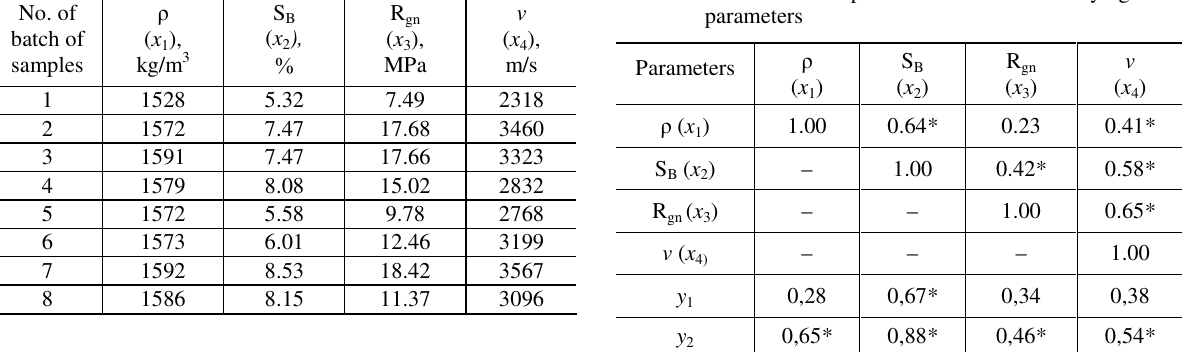
Table 5. The double correlative matrix of the analysed physical and mechanical parameters and selected drying